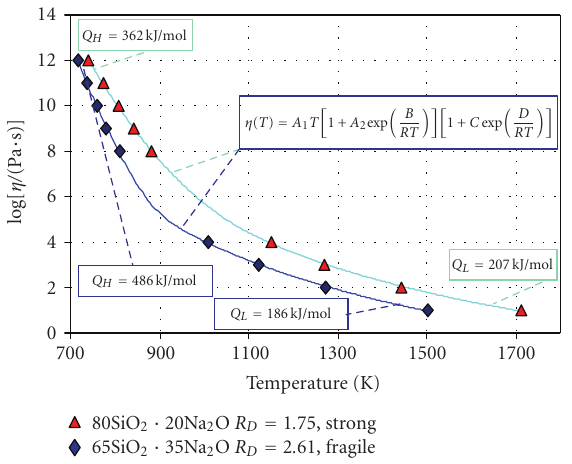
Figure 9: Viscosity of two SiO 2 –Na 2 O